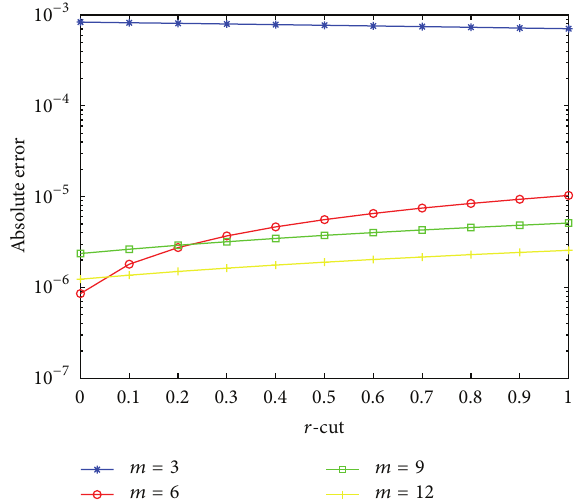
Figure 21: The fuzzy approximate solution of Example 64, 𝛼 = 0.75, 𝑚 = 3